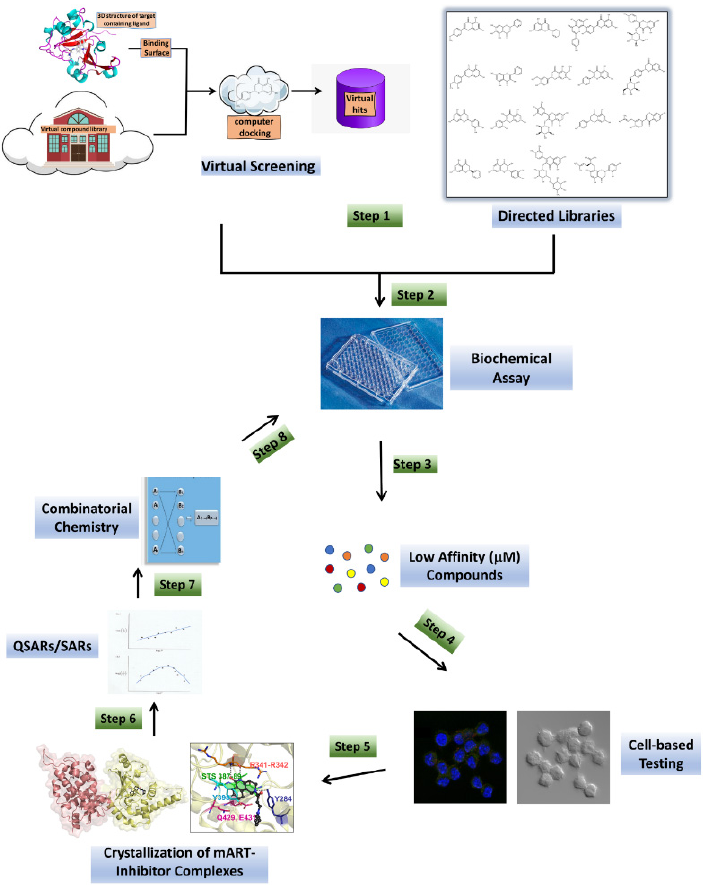
Figure 2. Anti-virulence development pipeline for mART toxins. mART inhibitors arise from Figure 2. Anti ‐ virulence development pipeline for mART toxins. mART inhibitors arise from two